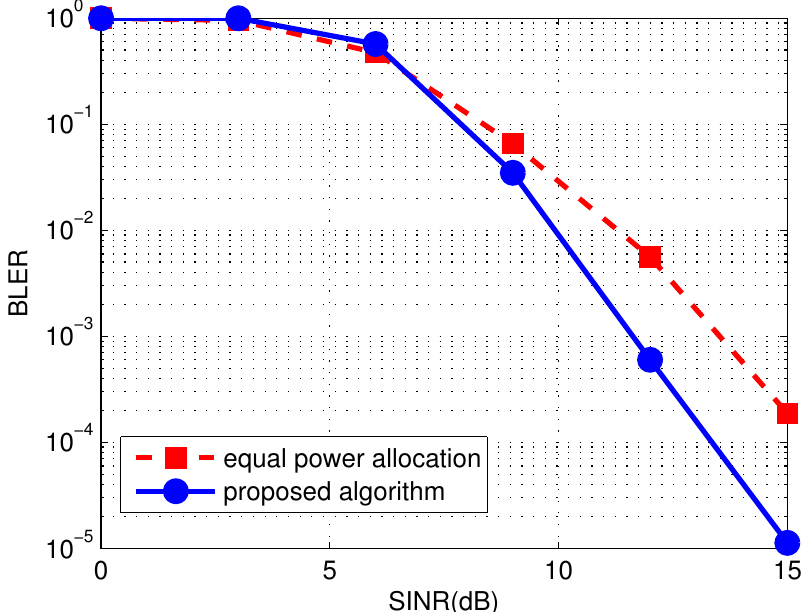
Figure 7. Block error rate (BLER) performance of SWIPT aided OFDM-IDMA system with the proposed power allocation algorithm and equal power allocation.The Cyclic Redundancy Check (CRC) sequence of length-16 is tailed at the end of each frame. K =